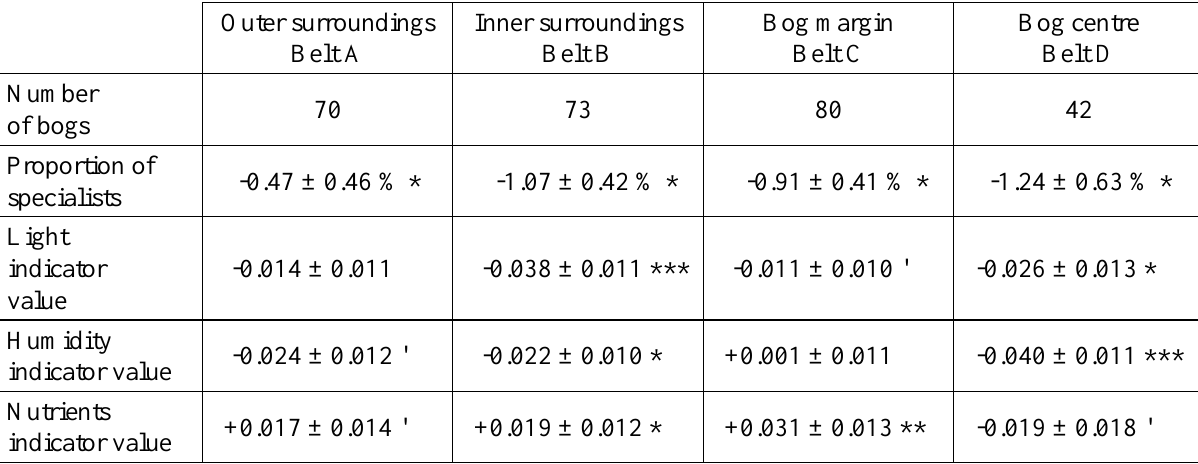
Table 7. Changes in Belts A, B, C and D for all of the bogs studied. Significance levels (signed rank sum test):